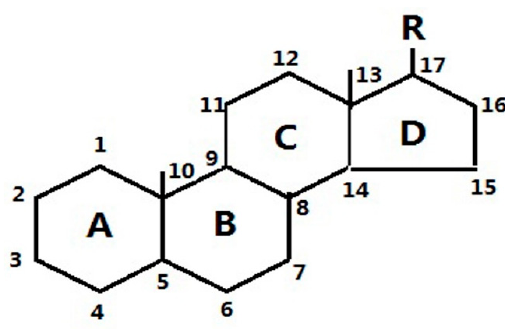
Figure 4. The common structure of steroids.